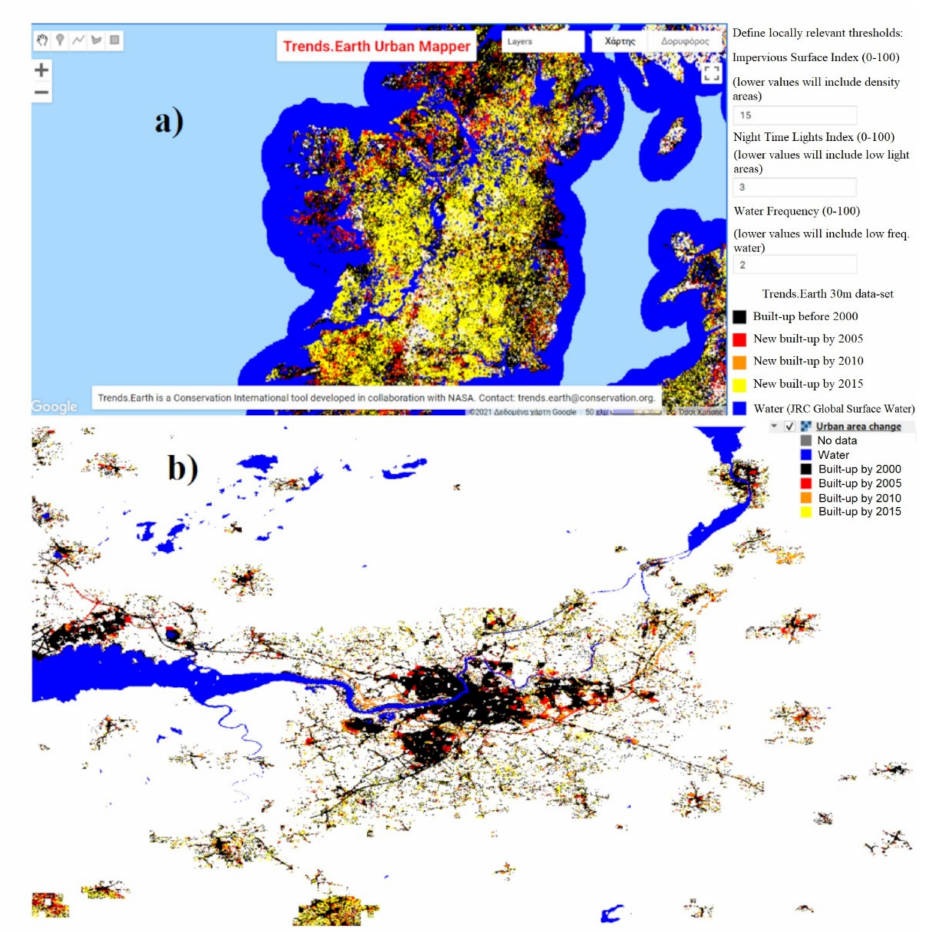
Figure 6. ( a ) Preparing input data, ( b ) zoom in the examined scale